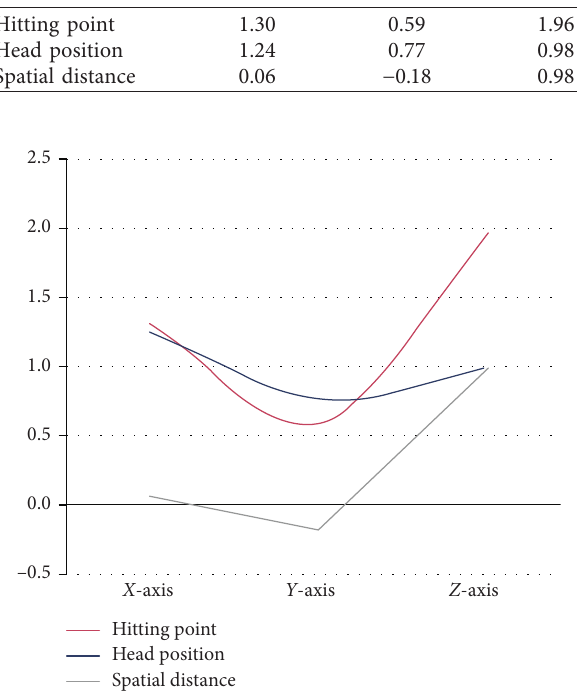
Figure 14: Statistical diagram of the three-dimensional distance between the hitting point and the head space position of the top spin (unit: m).